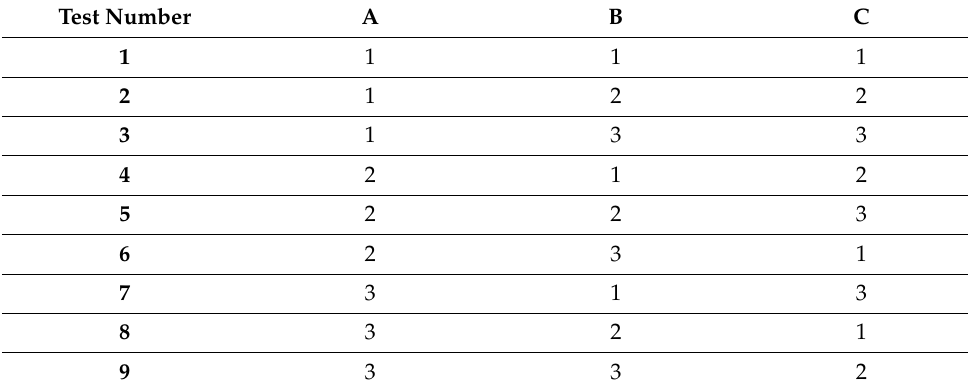
Table 2. Taguchi array for the tests.